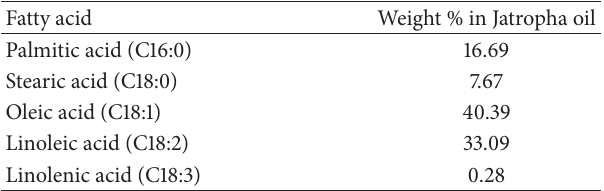
Table 1: Fatty acid composition of Jatropha oil (adapted from